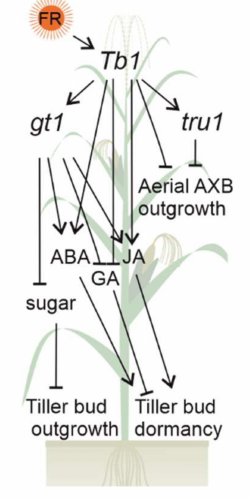
Figure 1. Regulation of maize plant architecture. TB1 regulates the outgrowth of aerial axillary buds and tillers via tru1 and gt1 , respectively. In addition, TB1 directly regulates the abscisic acid (ABA), gibberellic acid (GA) and jasmonic acid (JA) hormonal pathways to control tiller bud outgrowth. The gt1 -mediated route involves a sugar signaling pathway. FR = far red. Data adapted from [18] under CC-BY License (http://creativecommons.org/liceses/by/4.0/, accessed on 28 January